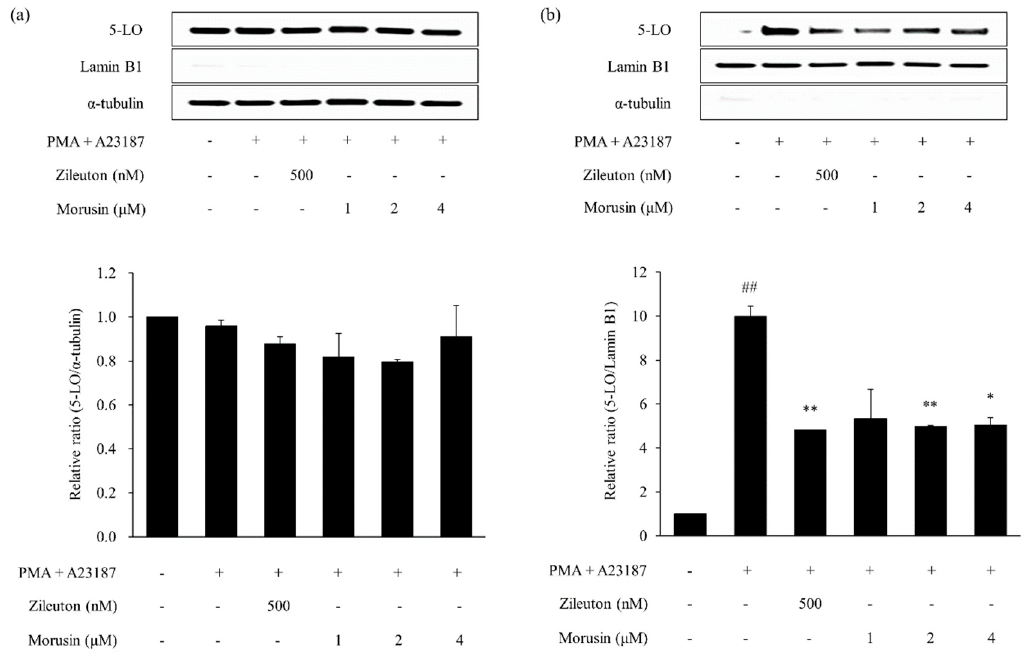
Figure 8. Effect of morusin on PMA and A23187-induce 5-LO activation in MC/9 mast cells. Expression of cytoplasmic ( a ) and nuclear ( b ) 5-LO was determined by Western blotting. Zileuton was used as the positive control. Data are expressed as the mean ± SEM ( n = 2). ## p < 0.01 versus vehicle control cells; * p < 0.05 and ** p < 0.01 versus PMA and A23187-treated cells.